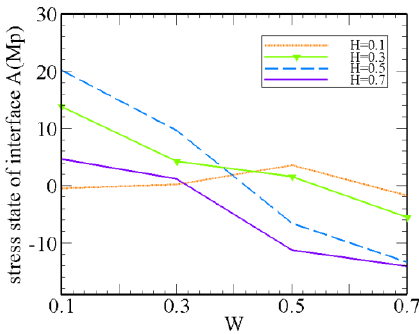
Figure 6. State of stress changes with texturing widths.